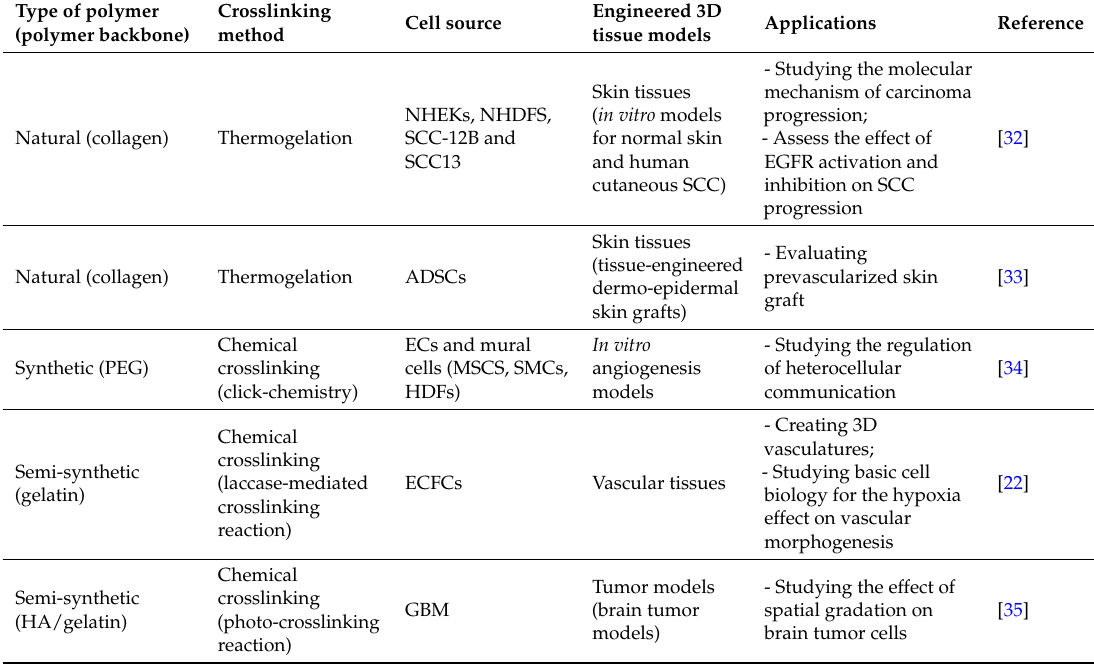
Table 1. Polymeric hydrogel matrices for engineered tissue models and their